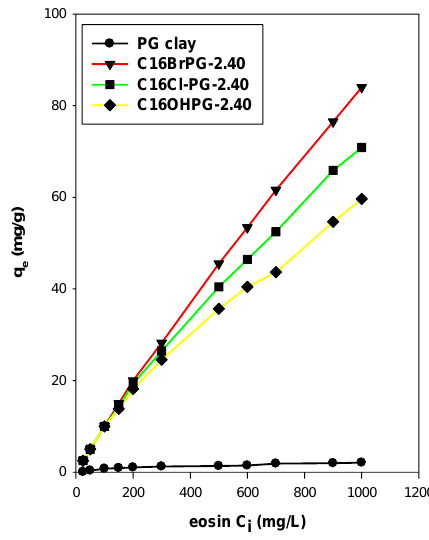
Figure 13. Removal of eosin at different initial concentrations by different OCs.